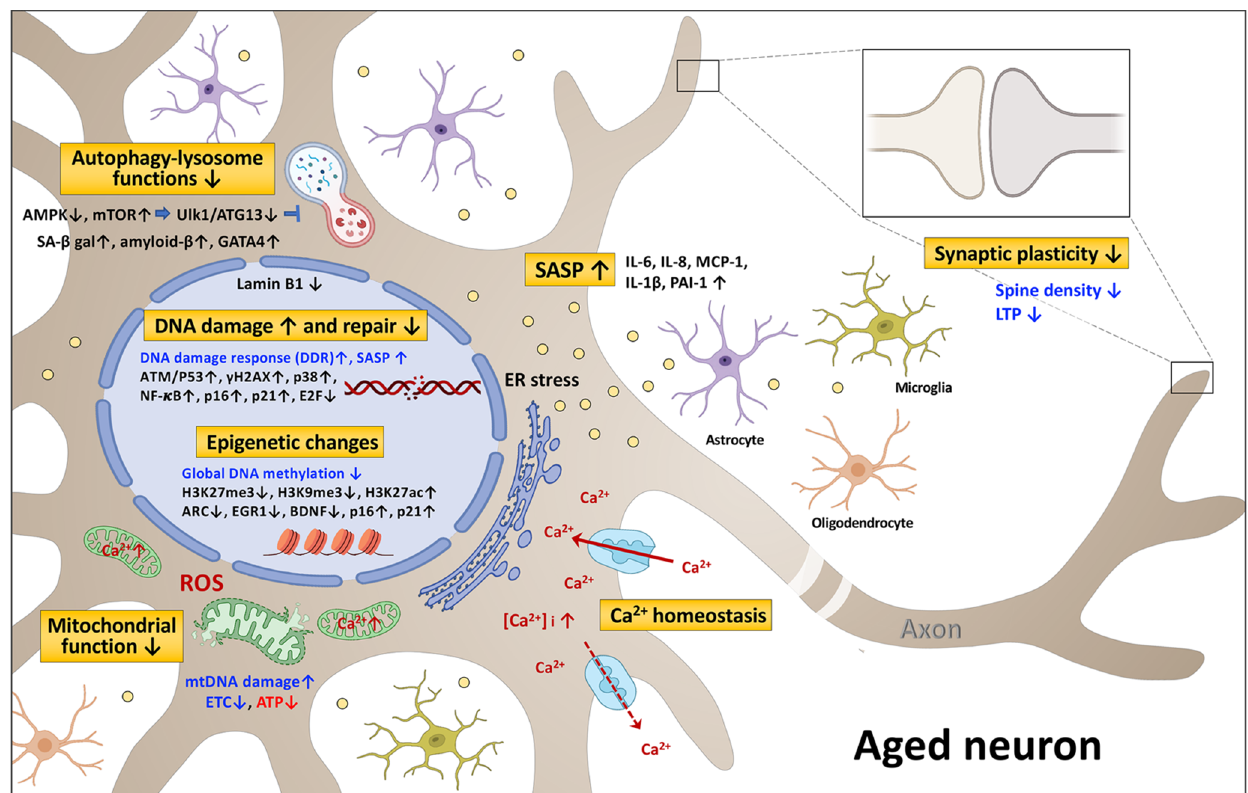
Figure 1. A schematic diagram of the signaling pathways associated with neuronal senescence and brain aging. Altered expression or activity of notable genes (black) in aged neurons are shown by up or down arrows, which indicate up or down regulation, respectively. The cellular processes affected are marked in blue. The metabolites are marked in red. The seven resulting brain-related functional changes are depicted. ER, endoplasmic reticulum; ROS, reactive oxygen species; SASP, senescence associated secretory phenotype. The figure was created with Biorender.com accessed on 19 October